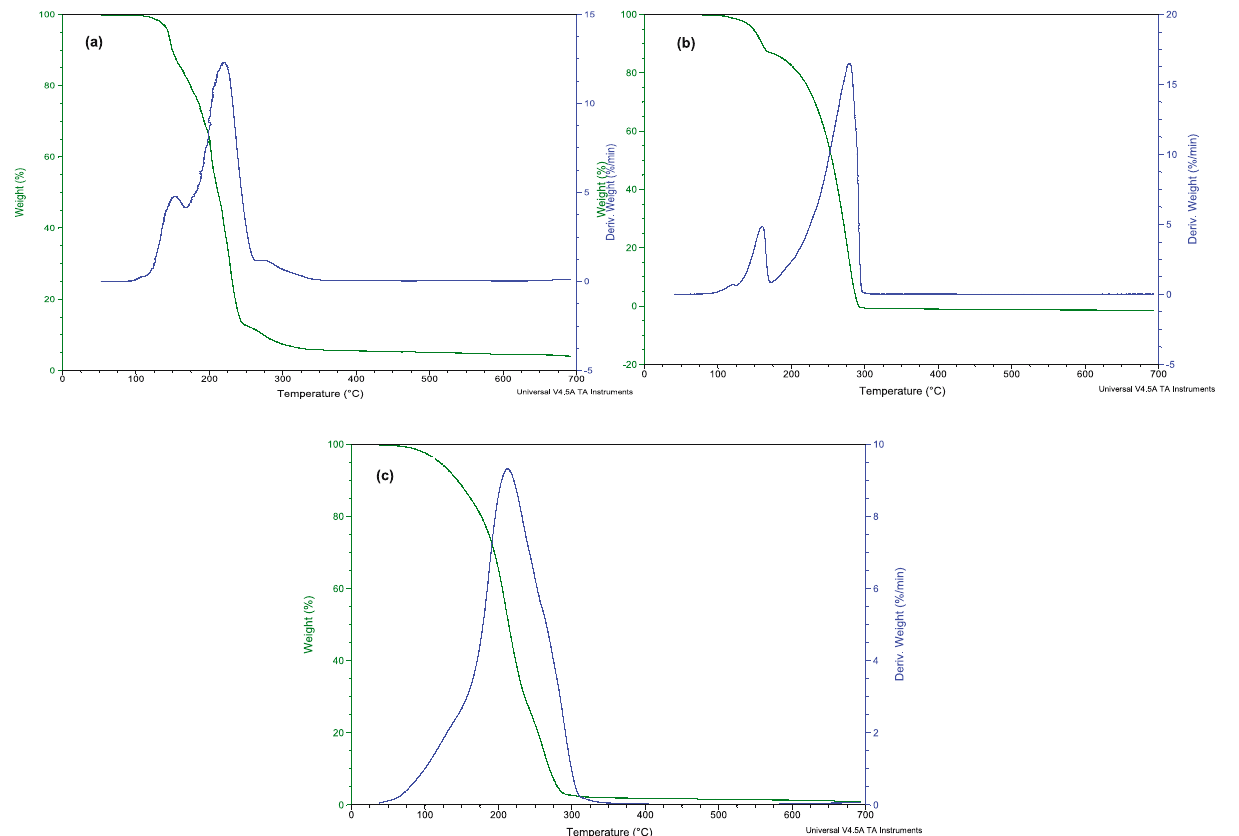
Figure 2: TG/DTG curves of complexes ( a ) 1 , ( b ) 2 , and ( c ) 3 obtained under a nitrogen atmosphere ( 75 mL min − 1 ) and heating rate of 10°C min − 1 at a temperature range of 50 – 700°C.